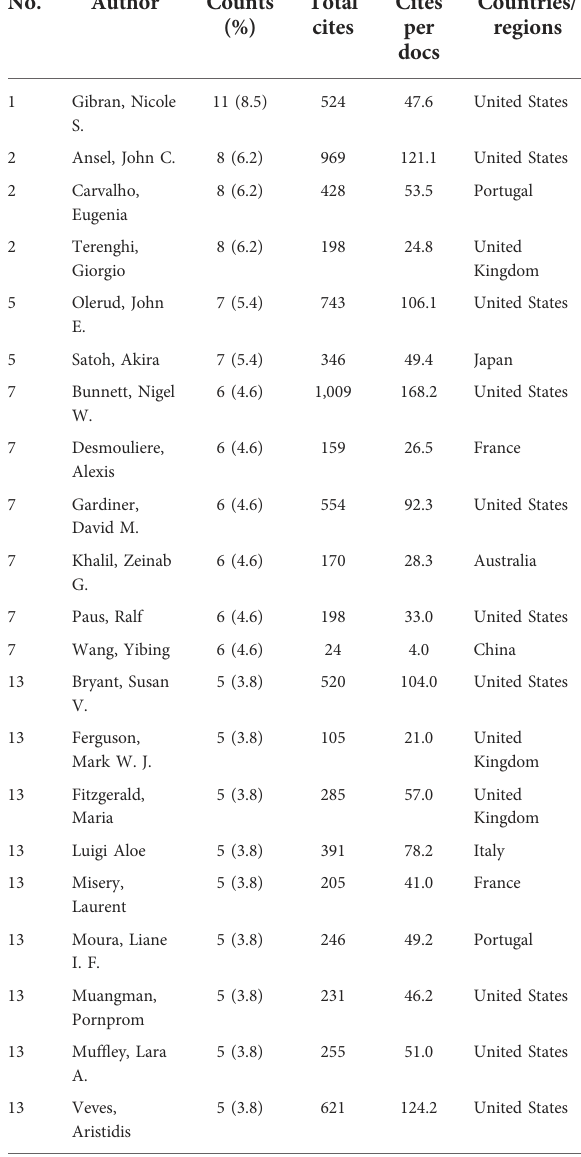
TABLE 4 Top 20 authors that published documents on the effects of skin innervation on wound healing. No.